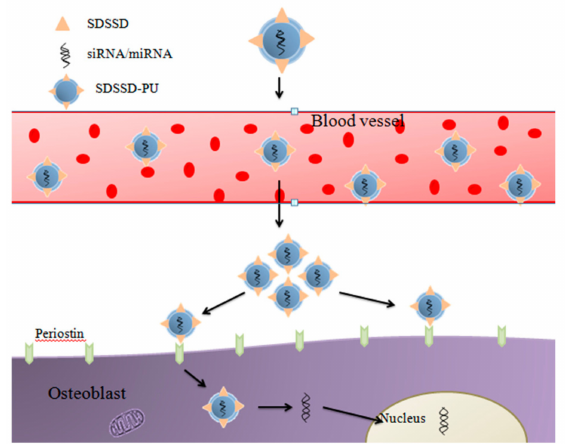
Figure 8. Schematic of SDSSD based delivery